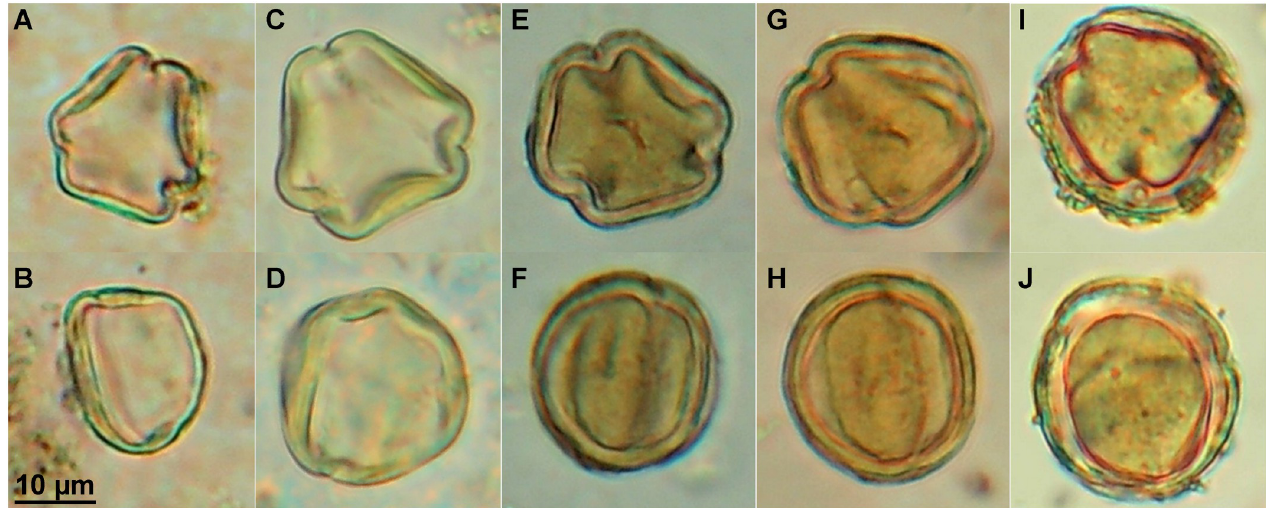
Fig 3. Vitis pollen in polar and equatorial view. Pollen grains recovered from: A, B. Fossil sediments from Rignano Flaminio (18–22 μ m); C, D. Surface of modern wild fruits of Vitis from Tivoli (20–24 μ m); E, F. Pitch of amphora SFC1; G, H. Pitch of amphora SFC5; I, J. Pitch of amphora SFC2.